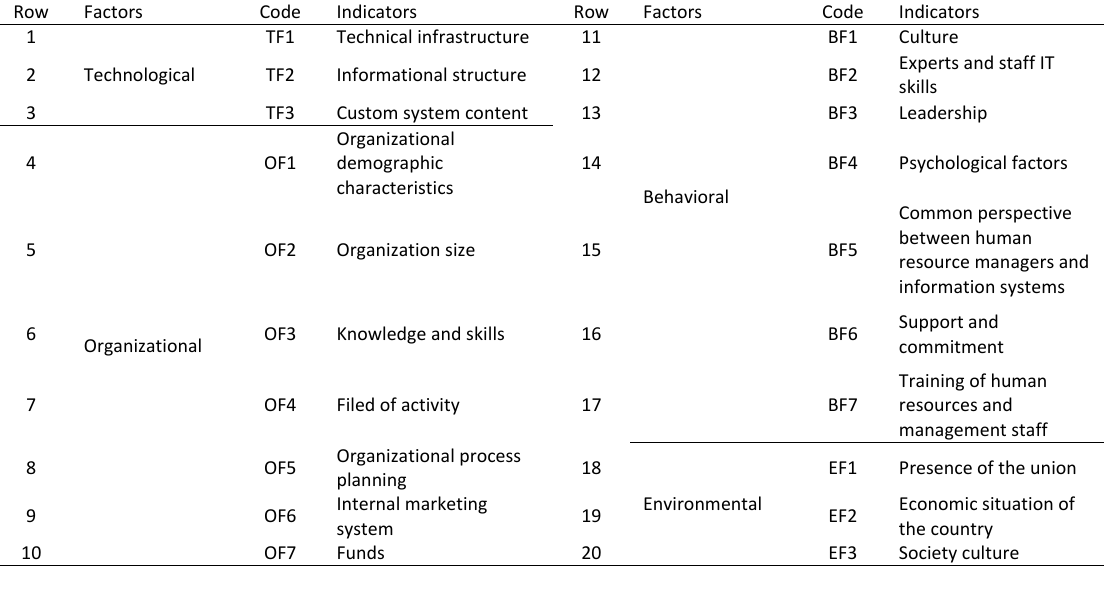
Table 4: The study factors and indicators